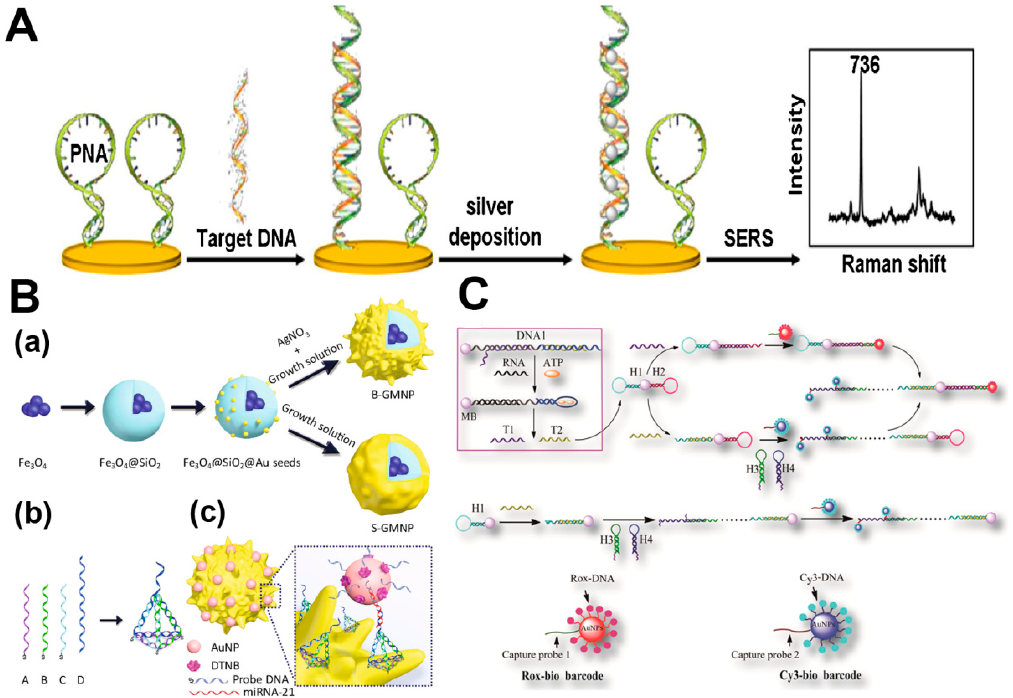
Figure 3. ( A ) Schematic of label-free strategy by using hairpin DNA [68]. ( B ) Sandwich strategy by